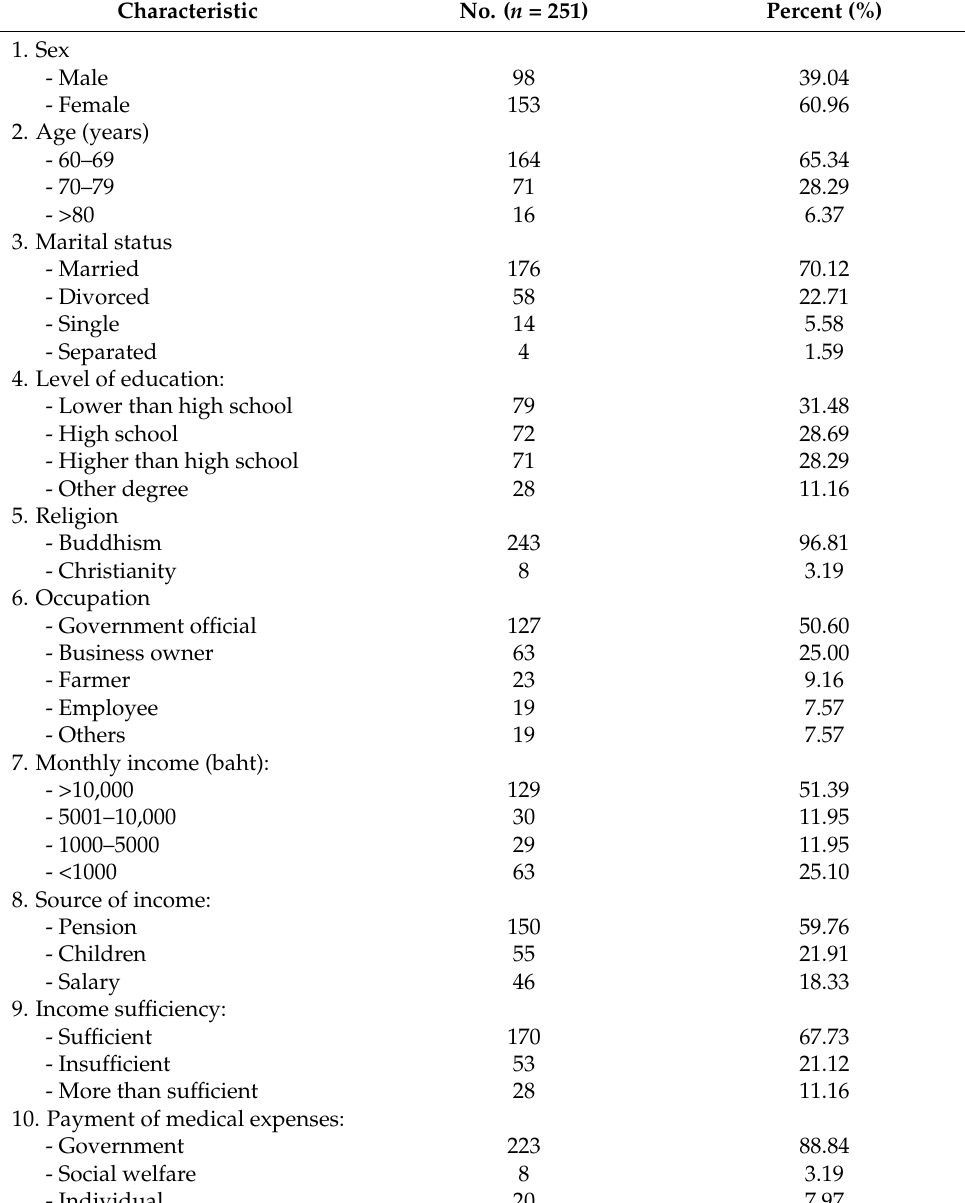
Table 1. Demographic characteristics of